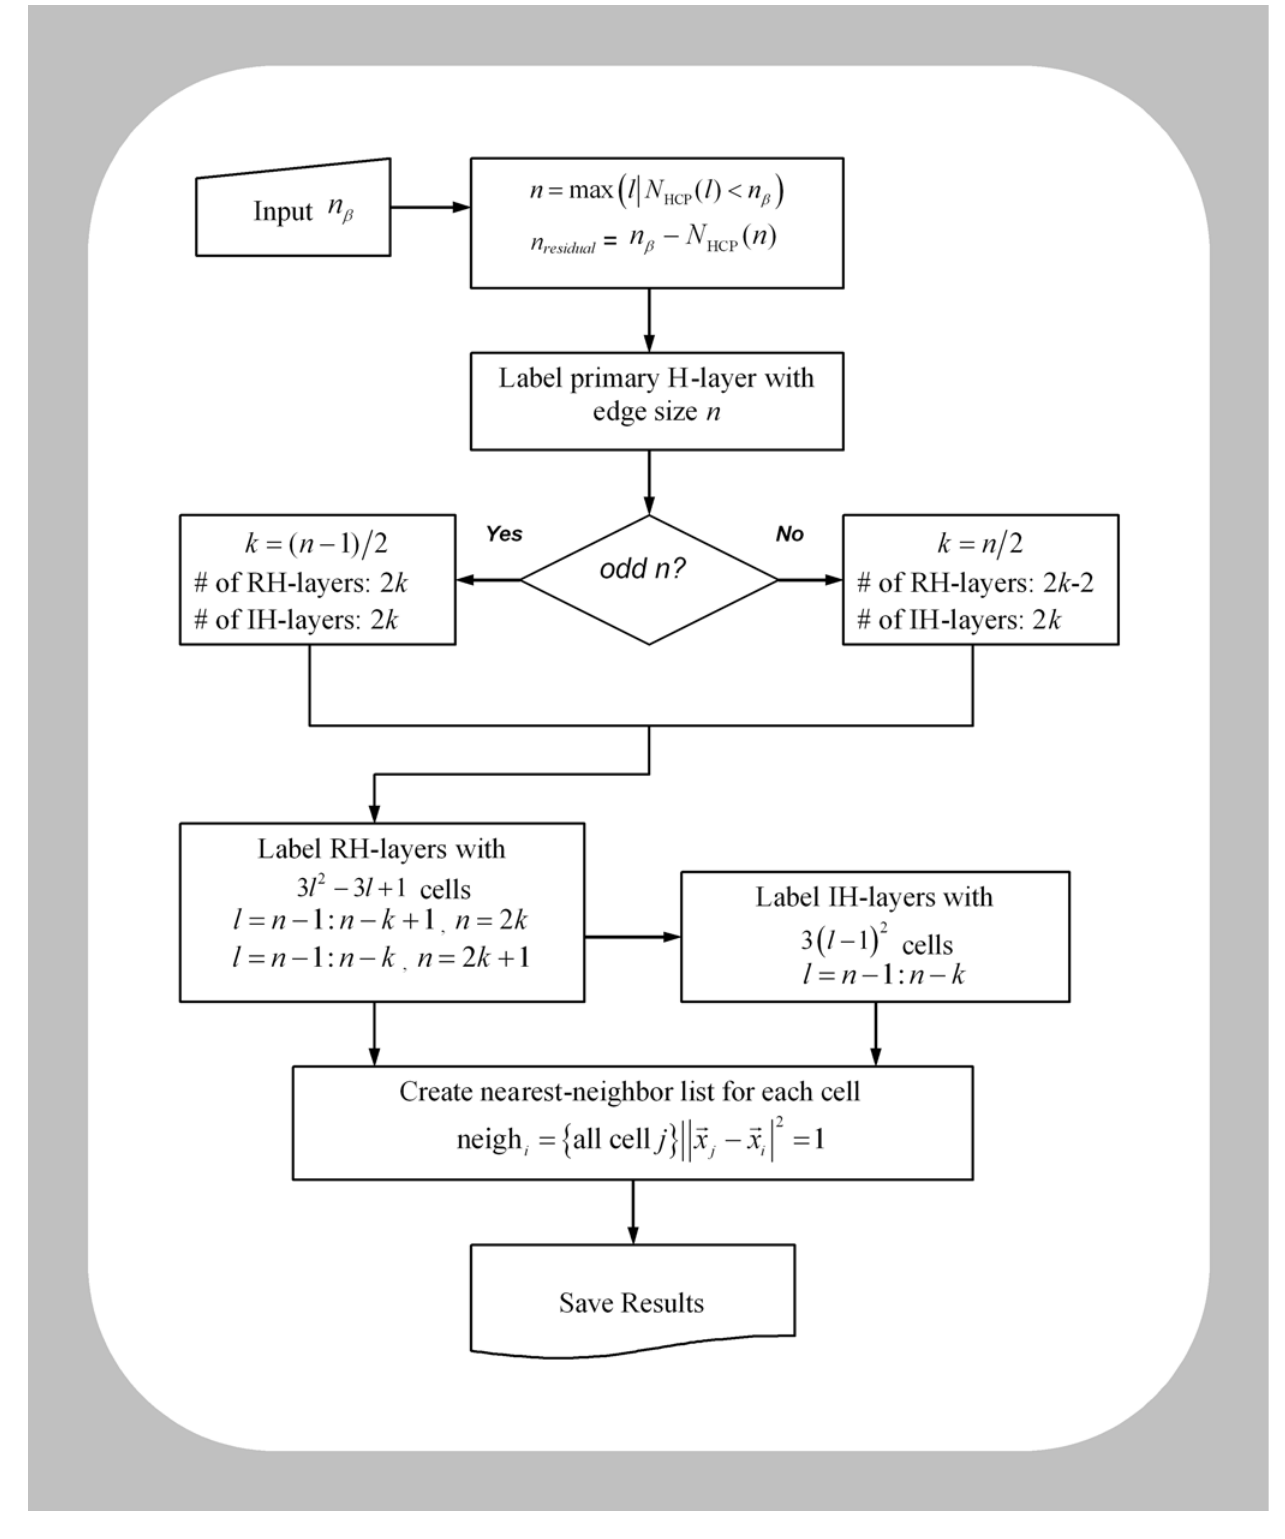
Figure 10. Scheme of cell labeling in an HCP b -cell cluster.